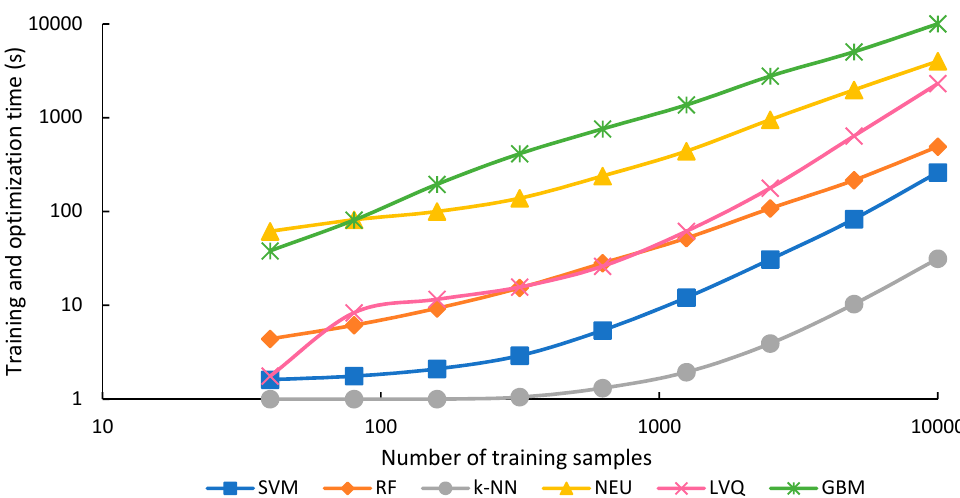
Figure 8. Training and optimization time in seconds and training set size. Please note that the x- and y-axis are on a log scale.